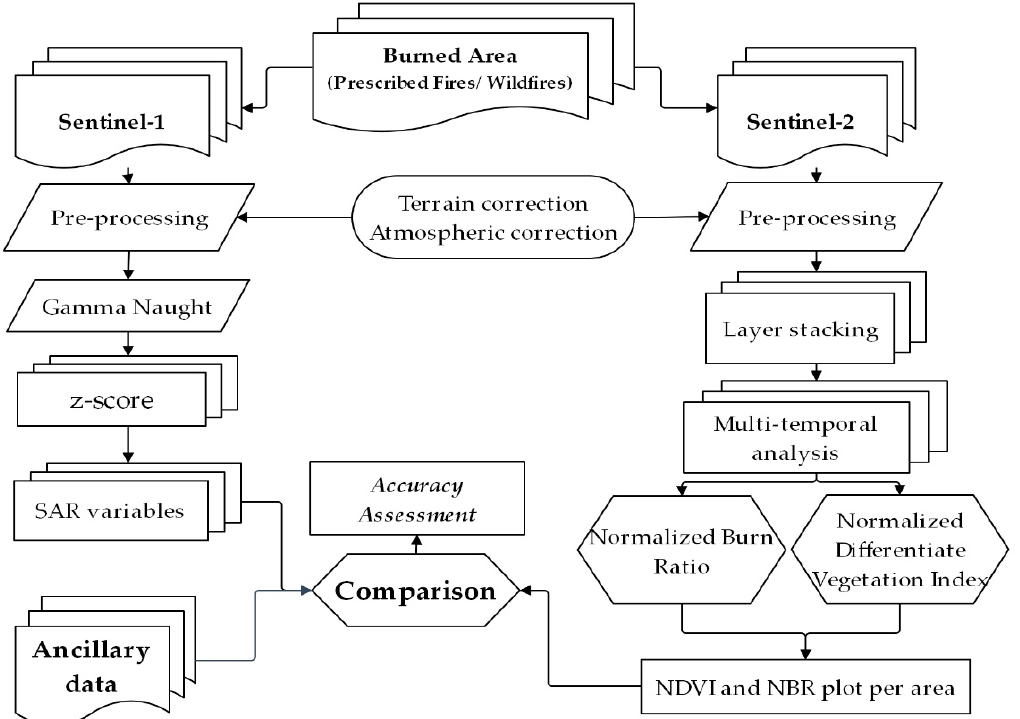
Figure 2. Summary of the methodology used in this paper.